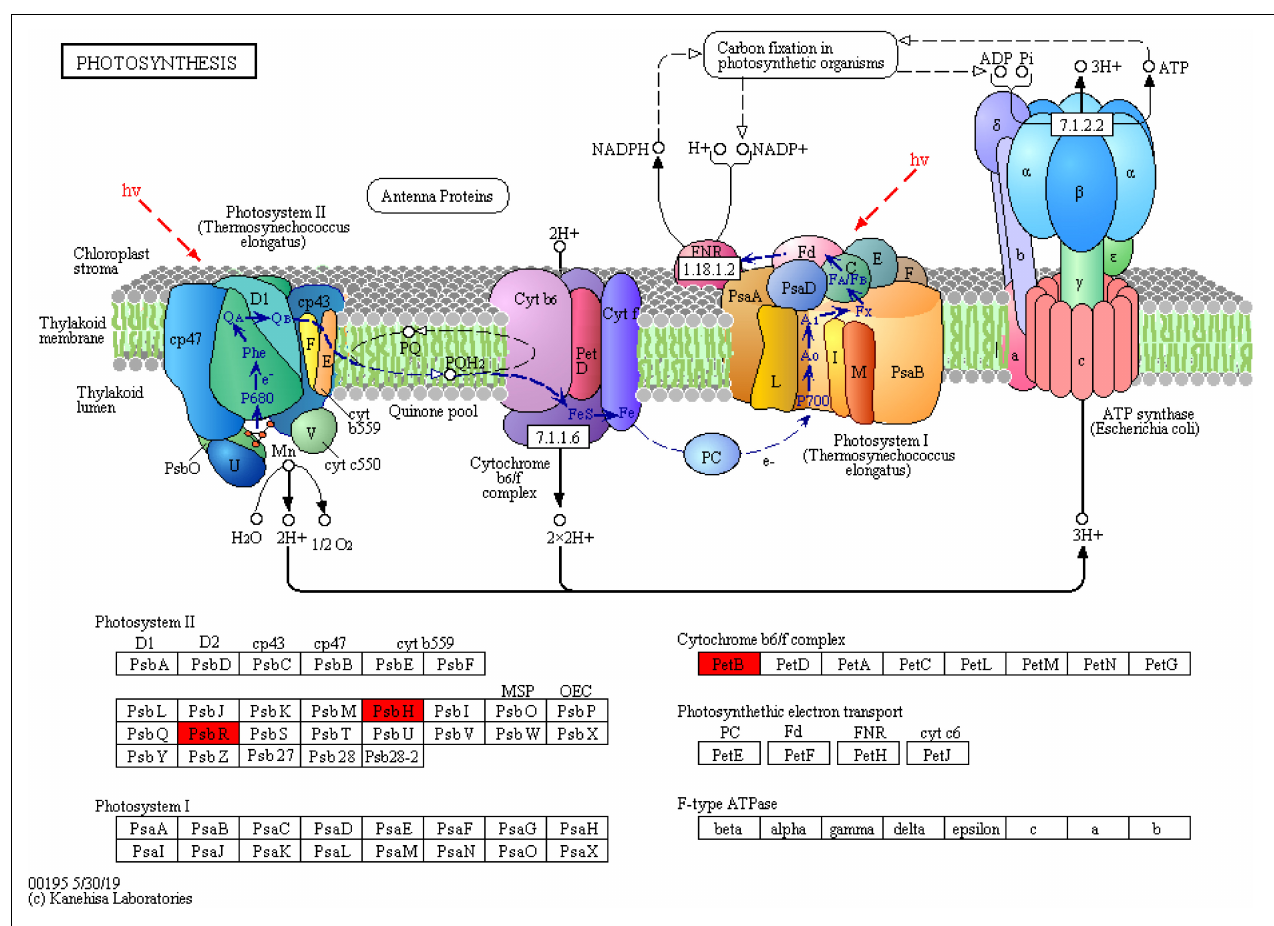
FIGURE 7 | DEPs involvement photosynthetic were mapped in the metabolic pathway by KEGG analysis (red represents upregulated